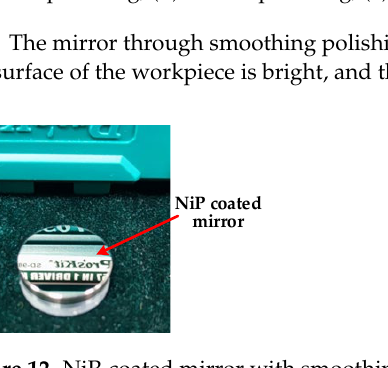
Figure 12. NiP-coated mirror with smoothing polishing.